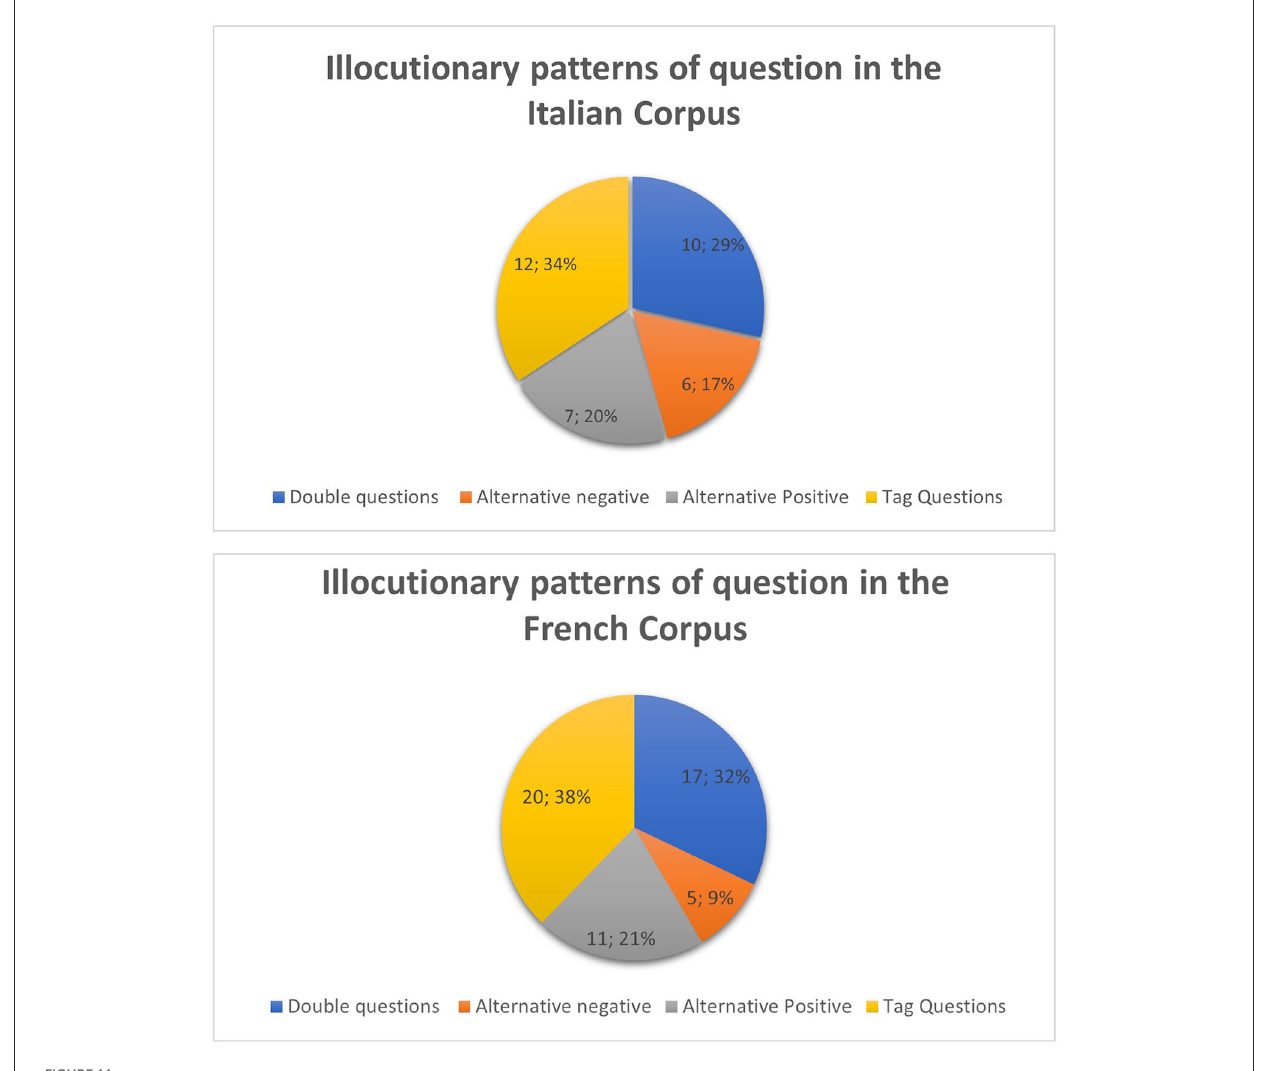
FIGURE11 Illocutionary patterns of question in the Italian and French